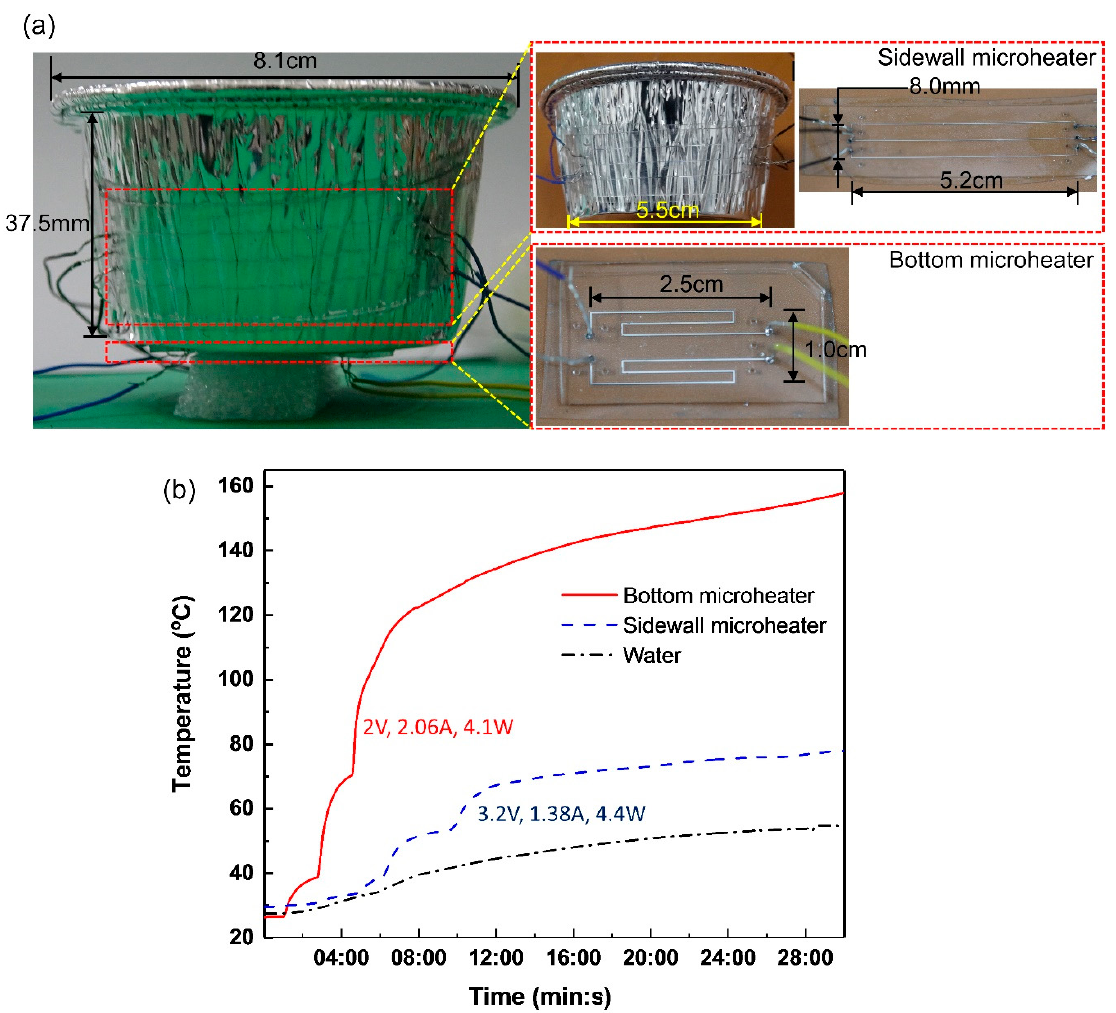
Figure 8. ( a ) Two microheaters are attached to the bottom and the sidewall of an aluminum-foil cup respectively. ( b ) Real-time temperature change of the bottom microheater, the sidewall microheater and the water in the cup.